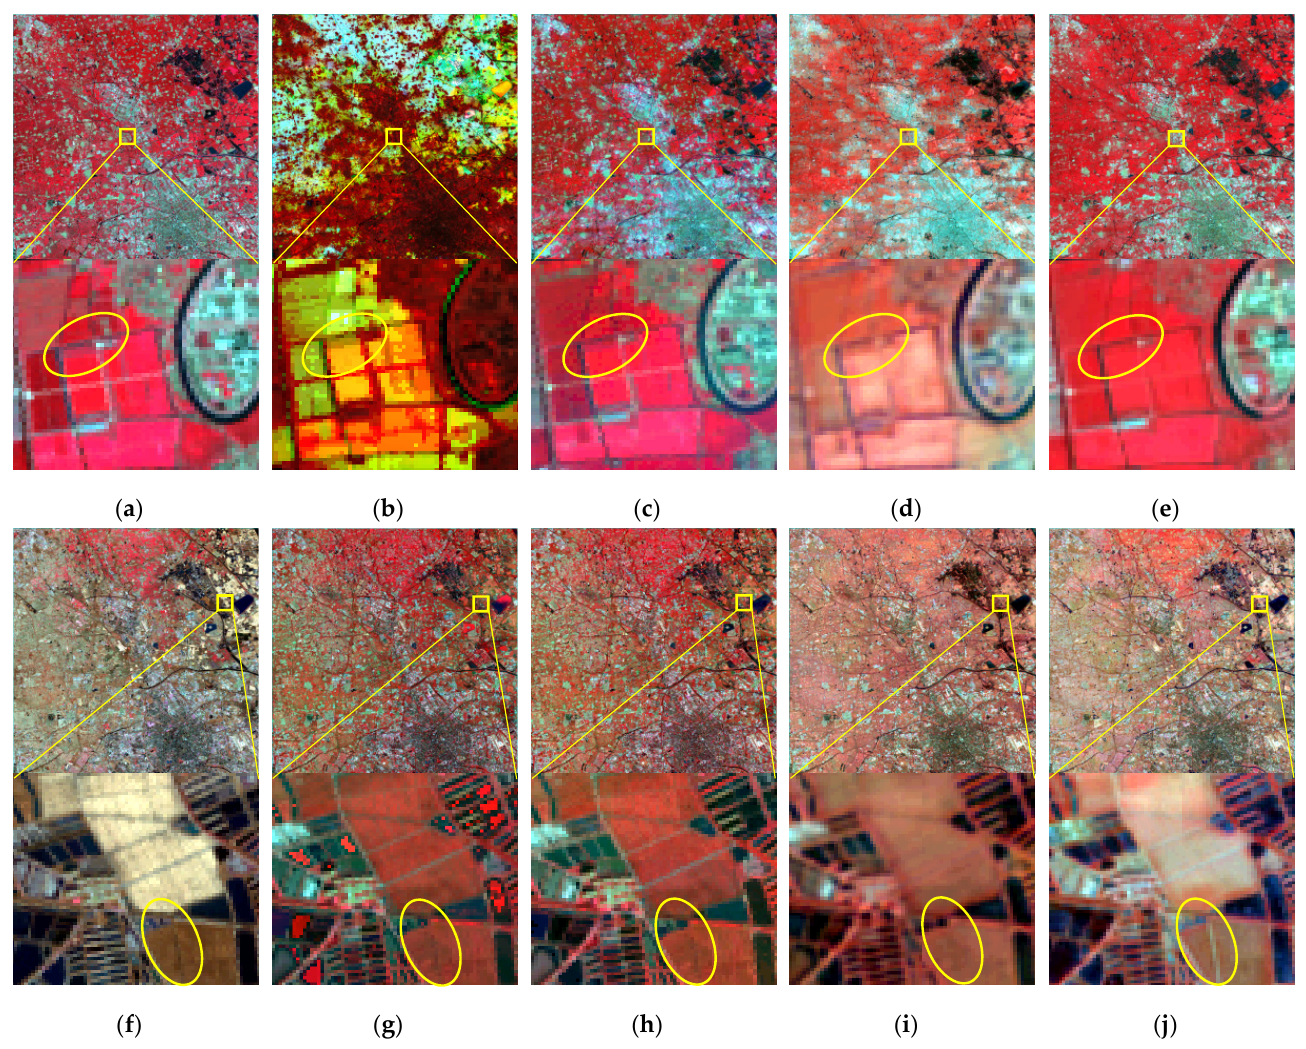
Figure 14. Experimental results based on the Tianjin dataset for spatiotemporal fusion: ( a , f ) Ground